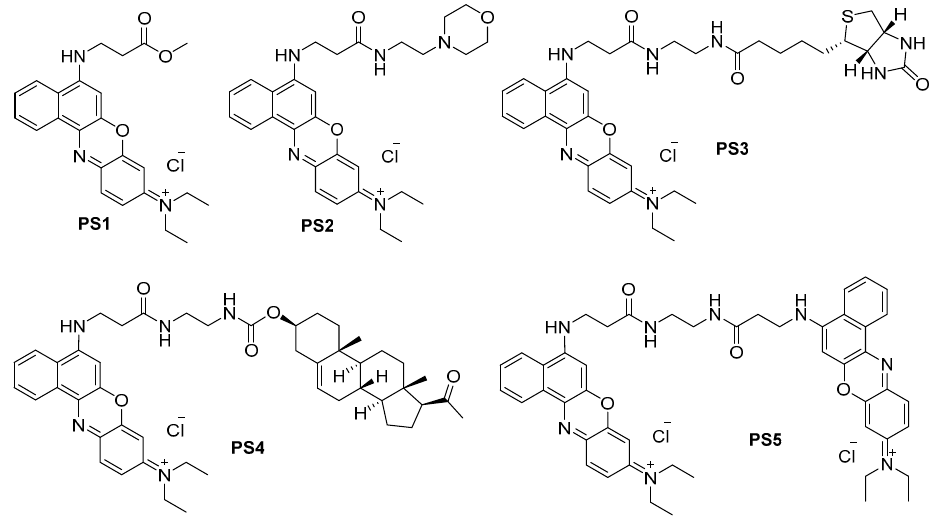
Figure 1. Structures of benzo[ a ]phenoxazinium chlorides PS1 – PS5 .